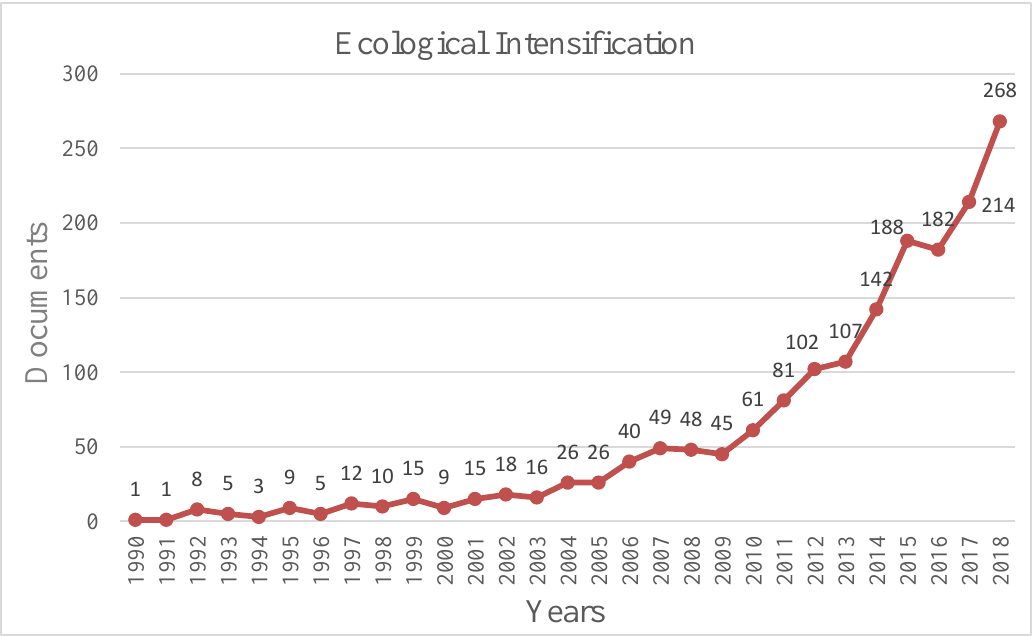
Figure 3. Literature number of ecological intensification issued in 1990–2018. Data Source: Web of Science Core Collection.